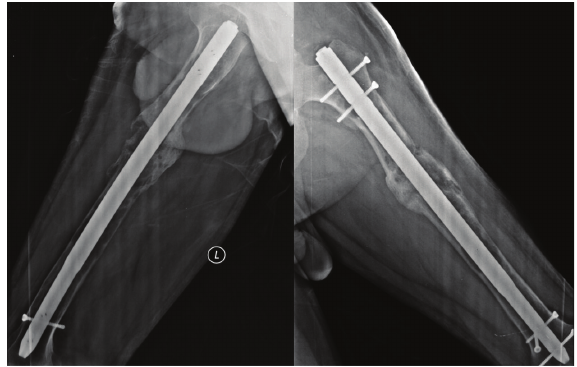
Figure 6: Pathological fracture treated with custom-made inter- locking intramedullary nail. Union is seen at the sixth month